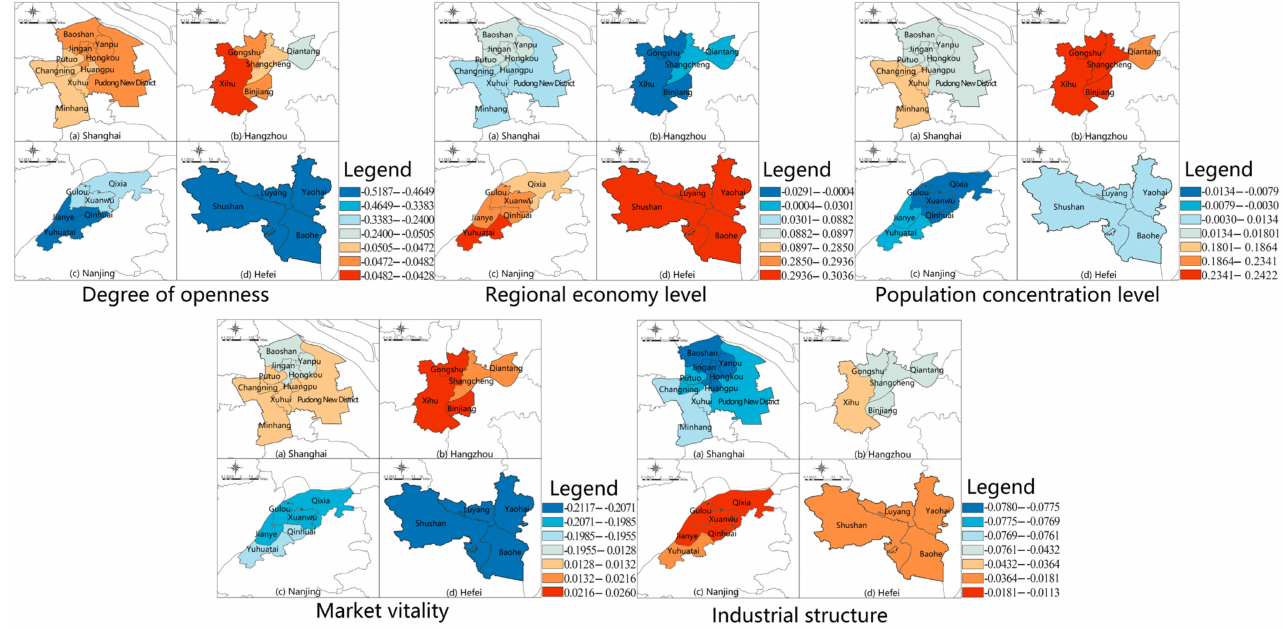
Figure 15. Spatial distribution of regression coefficients of GWR model of CDI in